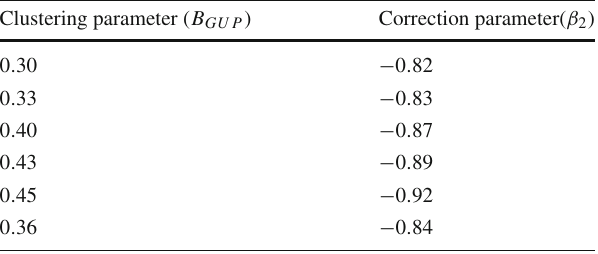
Table 2 The table shows various values of β 2 for different values of clustering parameter B GUP Clustering parameter ( B GUP )